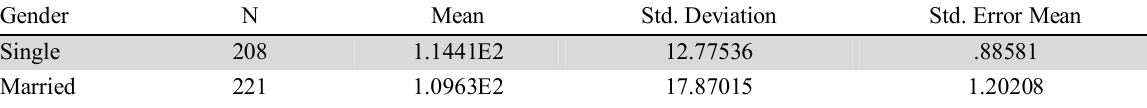
Sig. Mean Std. Error (2-tailed) Difference Difference